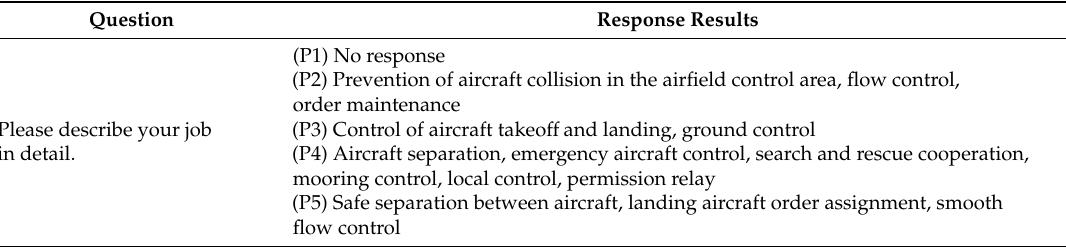
Table 1. Questionnaire